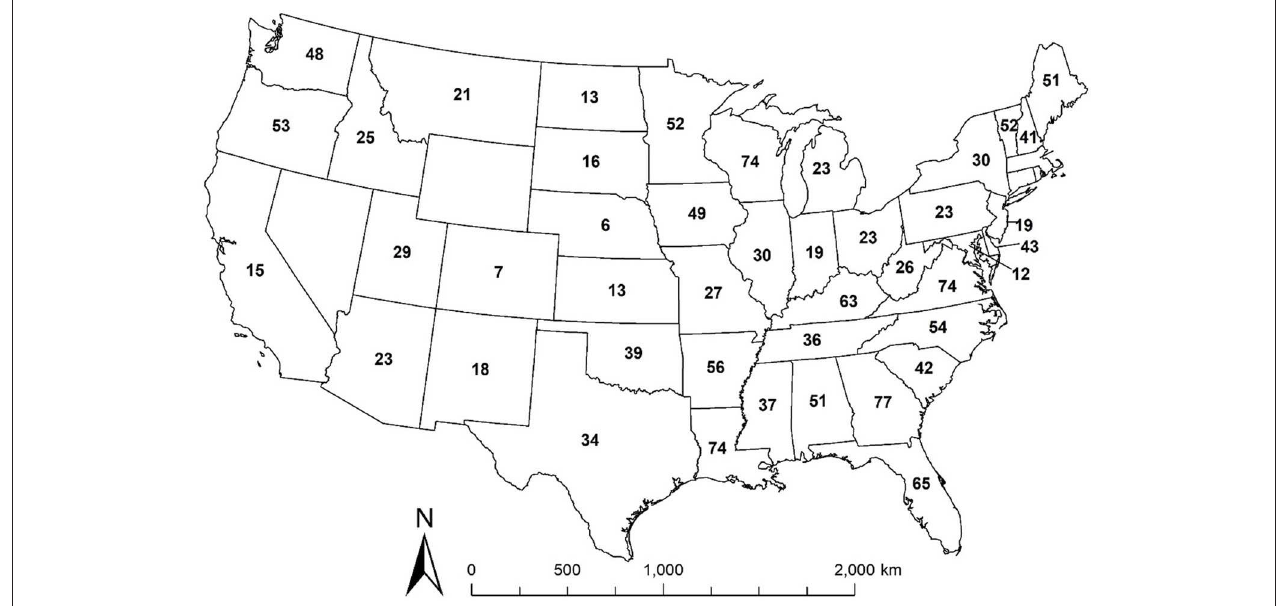
FIGURE 5 | Percent of soil samples, which need yearly K additions to prevent loss of profit for the majority of agricultural crops in 2005 for different states in the contiguous United States (modified from Fixen et al., 2007).